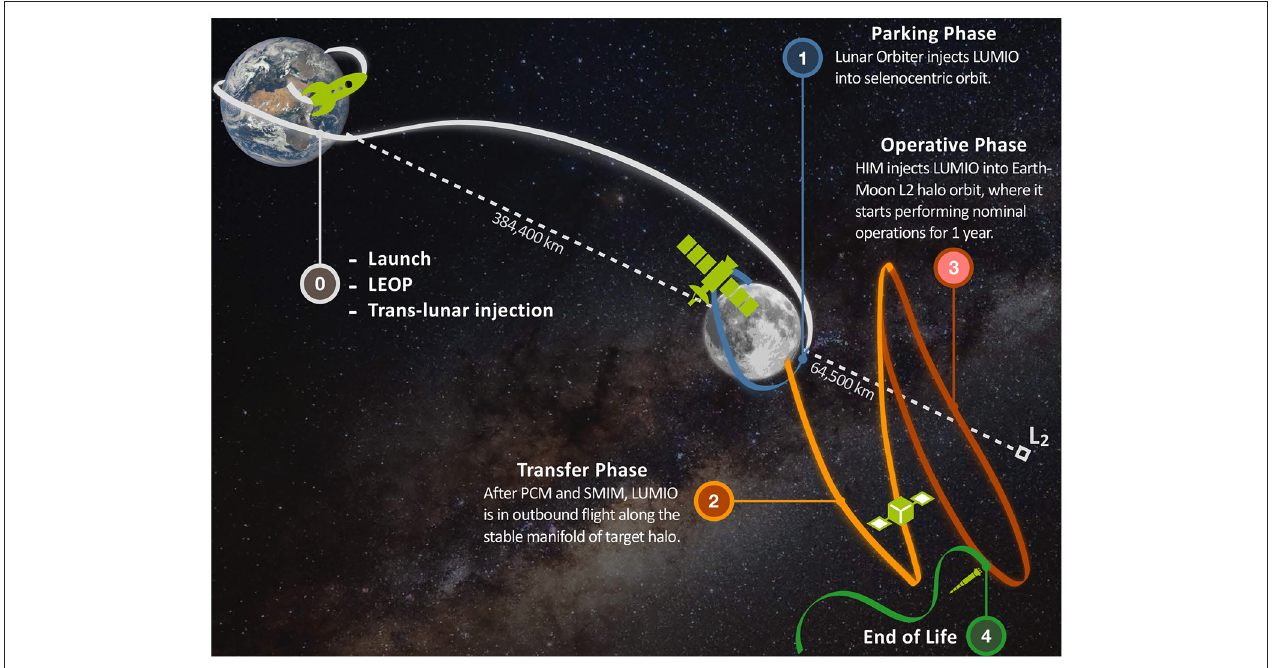
FIGURE 5 | Outline of LUMIO mission phases.